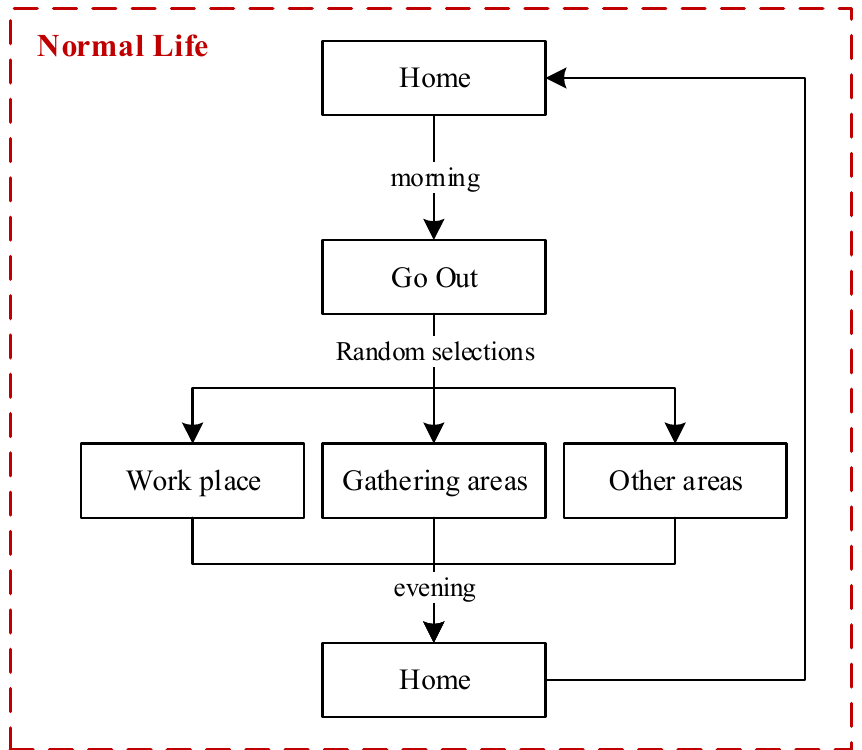
Figure 4. Flow chart of a person living a normal life.